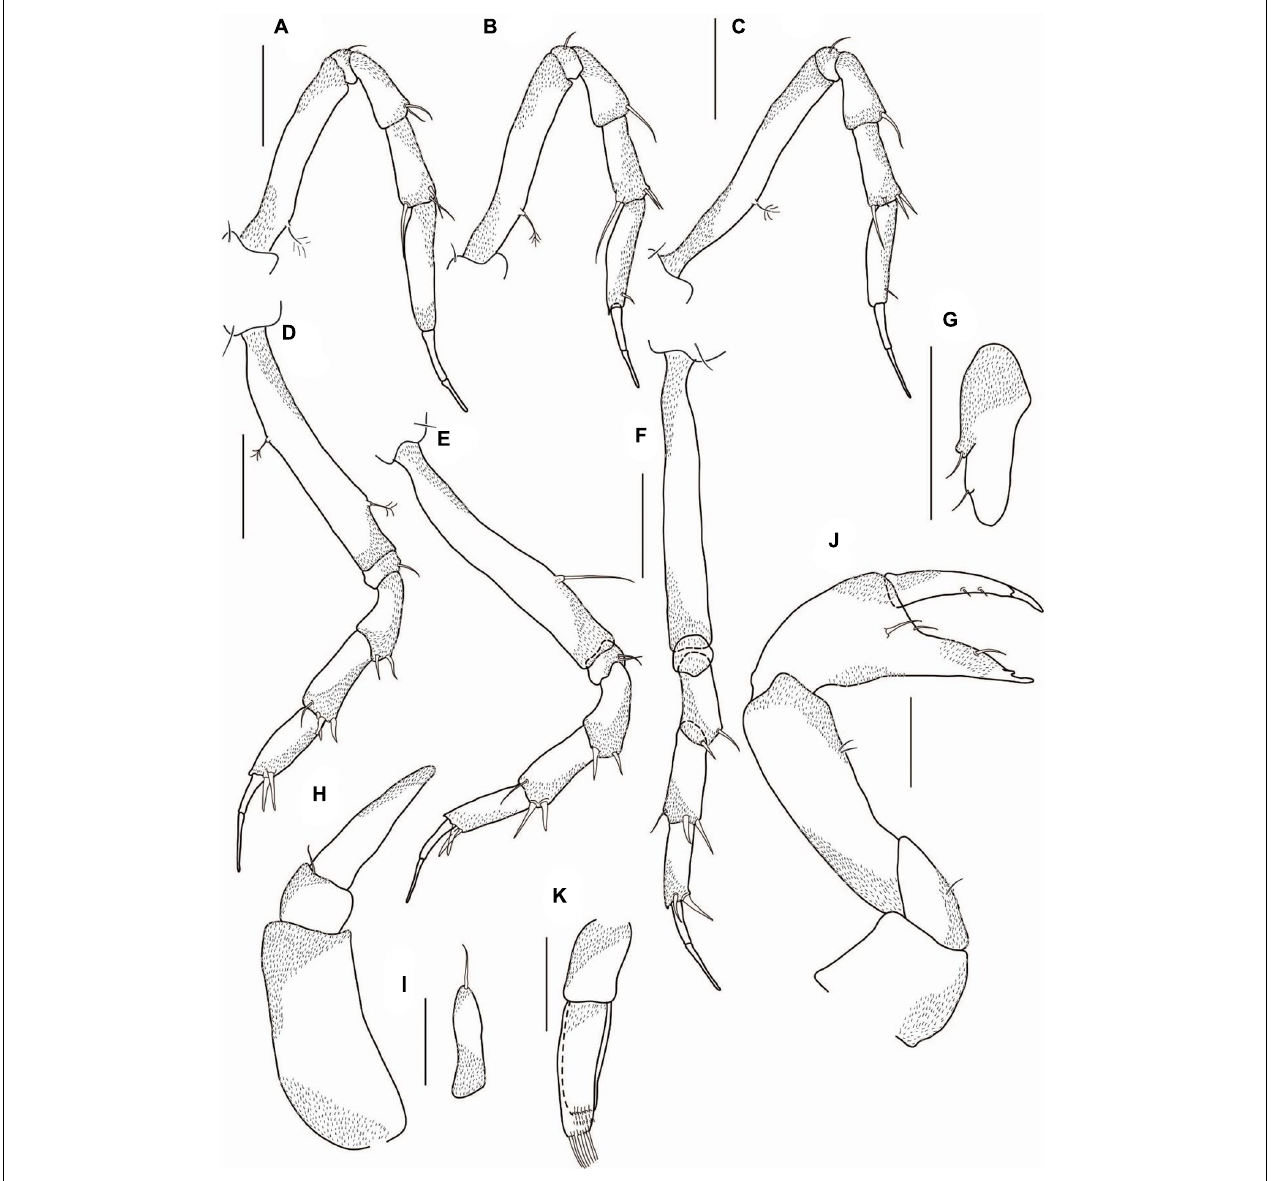
FIGURE 7 | Agathotanais frutosae n. sp., neuter, paratypes ( A–G : NHM 58034); juvenile male, paratype ( H–K : ZMH K-61184). (A) peropod-1; (B) pereopod-2; (C) pereopod-3; (D) pereopod-4; (E) pereopod-5; (F) pereopod-6; (G) uropod; (H) antennule; (I) antenna; (J) cheliped; (K) pleopod. Scale bar: (A–K) = 100 µ m.